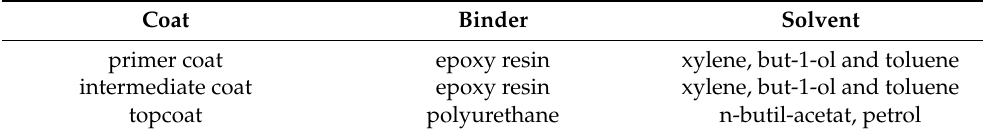
Table 3. Preparation of three-layer coating system on carbon steel